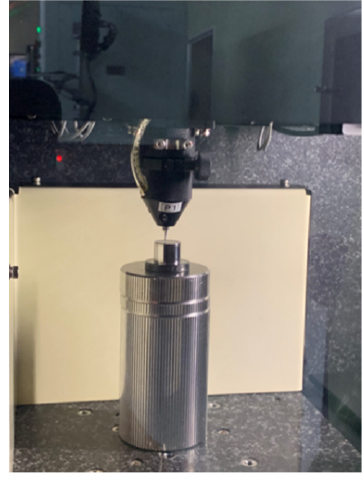
Figure 7. Mold measurement. Figure 7. Mold